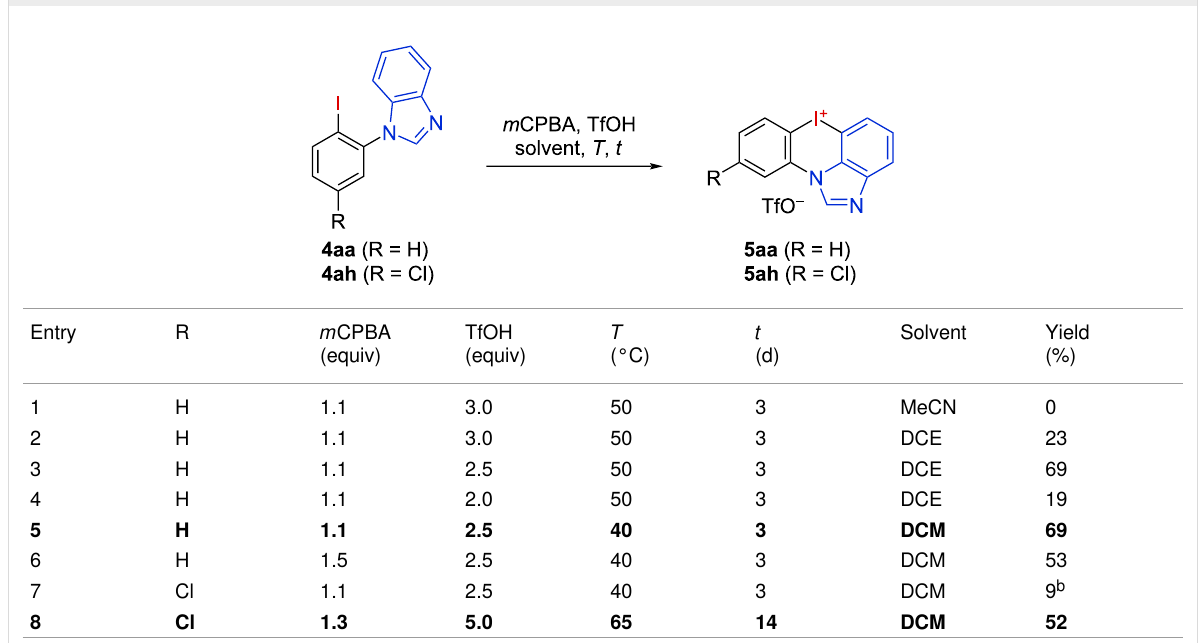
Table 1: Optimization of reaction conditions for the synthesis of azoiodazinium salts 5aa and 5ah .